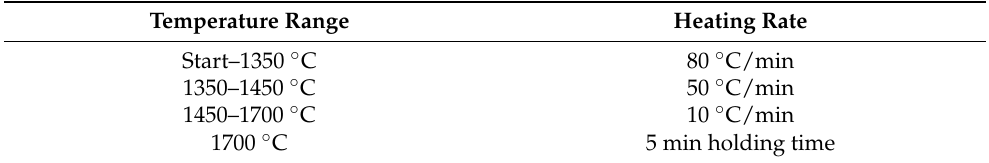
Table 1. Standardized heating program in the heating microscope for investigations of the high- temperature behavior of NCA with different